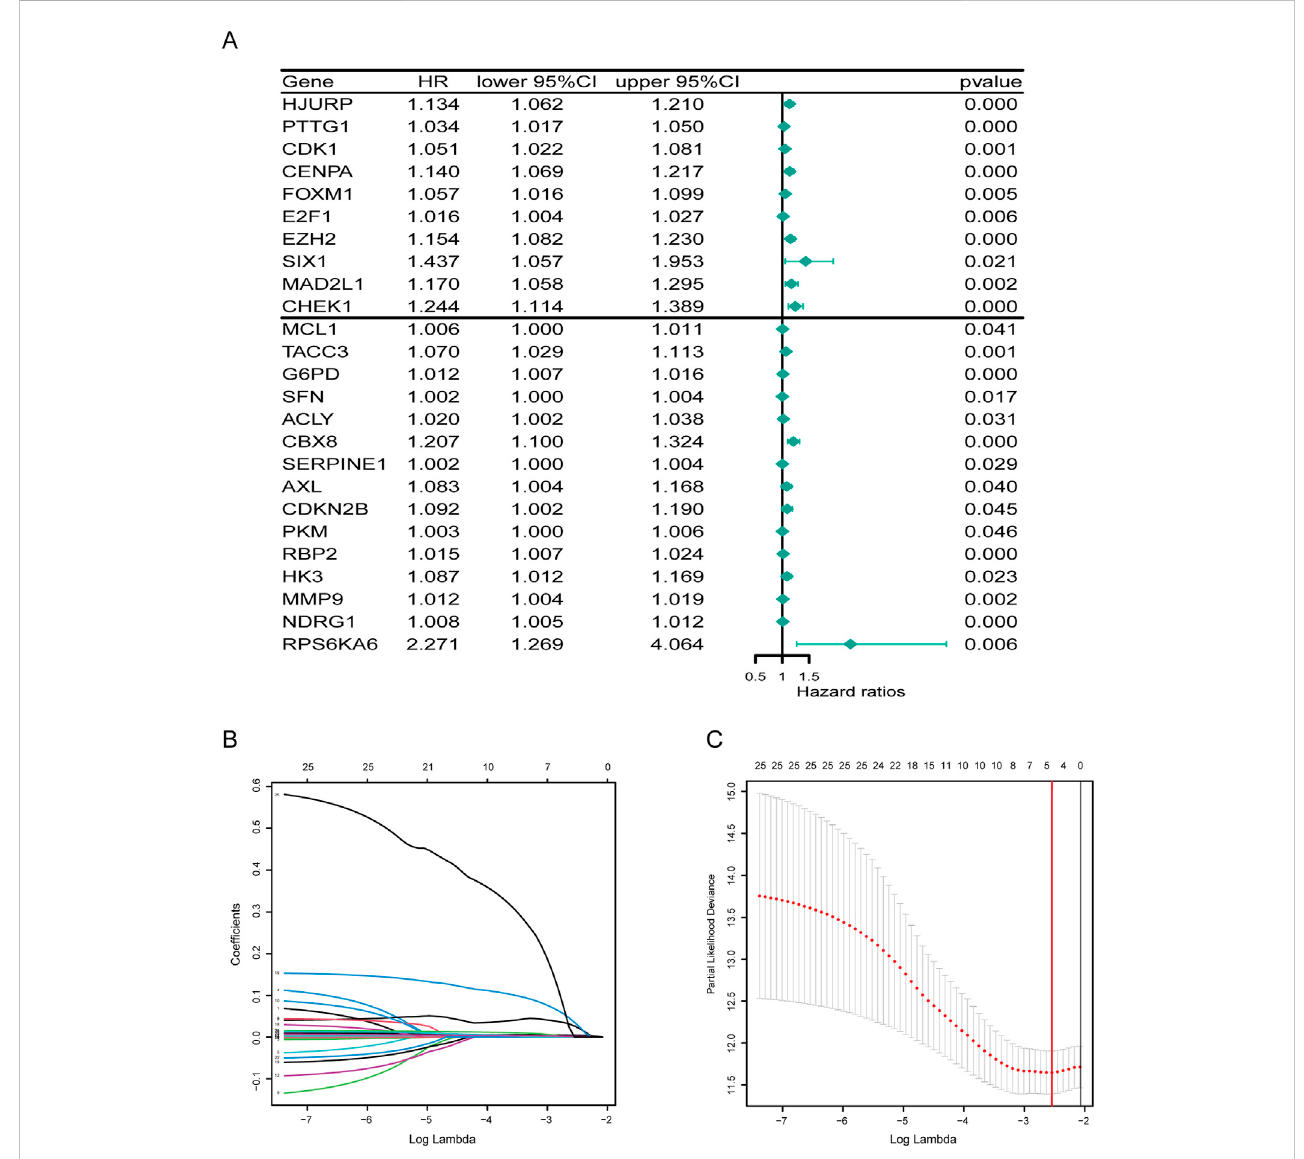
Developing a prognostic signature. (A) Forest plot of 25 cellular senescence-related genes associated with HCC prognosis. (B) The coef fi cients in the LASSO regression model for CSGs. (C) A minimum value of λ was chosen as optimal. The red linerepresents those 25 features that were reduced to four non- zero coef fi cient features by